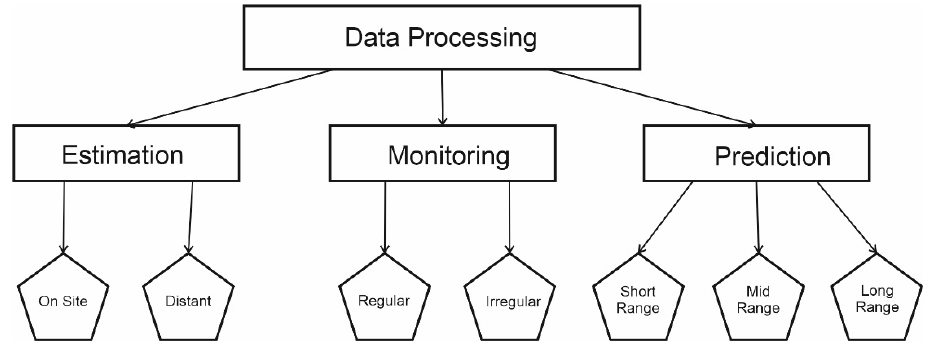
Figure 1. Types of information processing on forest fire danger.